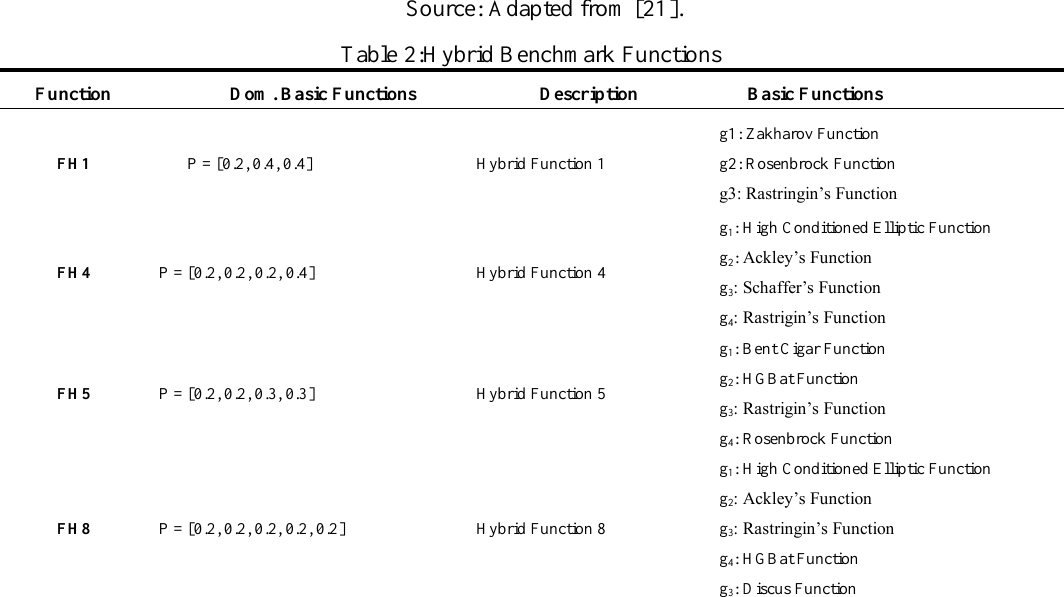
Table 2:Hybrid Benchmark Functions